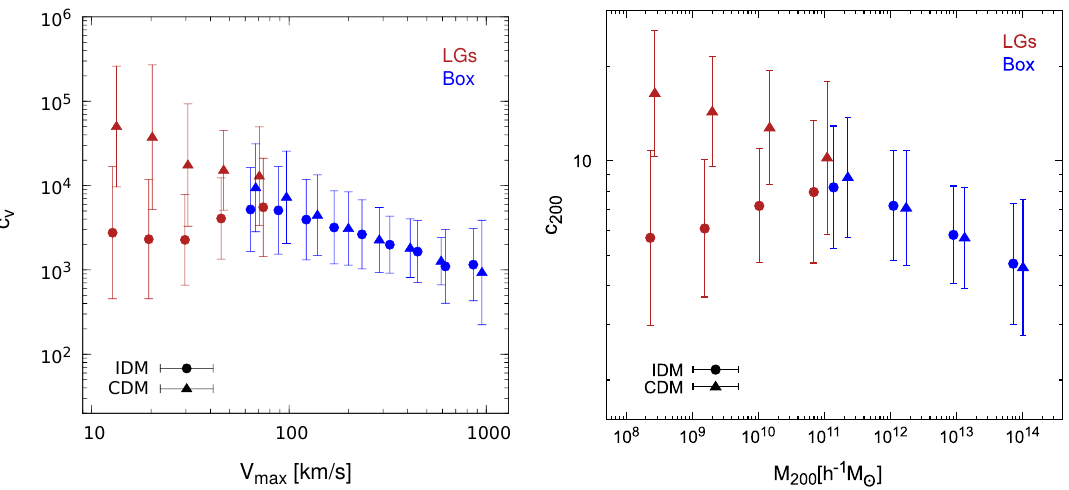
Figure 1. Median halo concentrations and 1 σ errors as found in our set of simulations, Box (blue) and LGs (red), at z = 0. ( a ) Left panel: median c V values as a function of V max . ( b ) Right panel: c 200 as a function of M 200 . In both panels, the circle symbols refer to the IDM simulations, whereas the triangles to